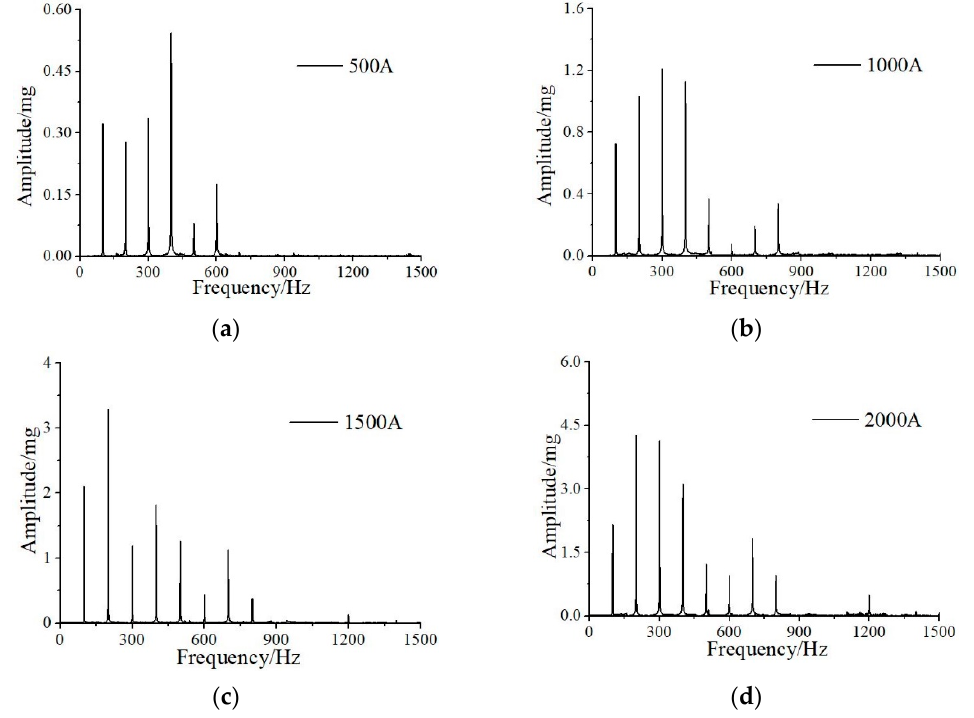
Figure 12. Frequency domain waveforms under the normal case: ( a ) 500 A; ( b ) 1000 A; ( c ) 1500 A; ( d ) 2000 A.